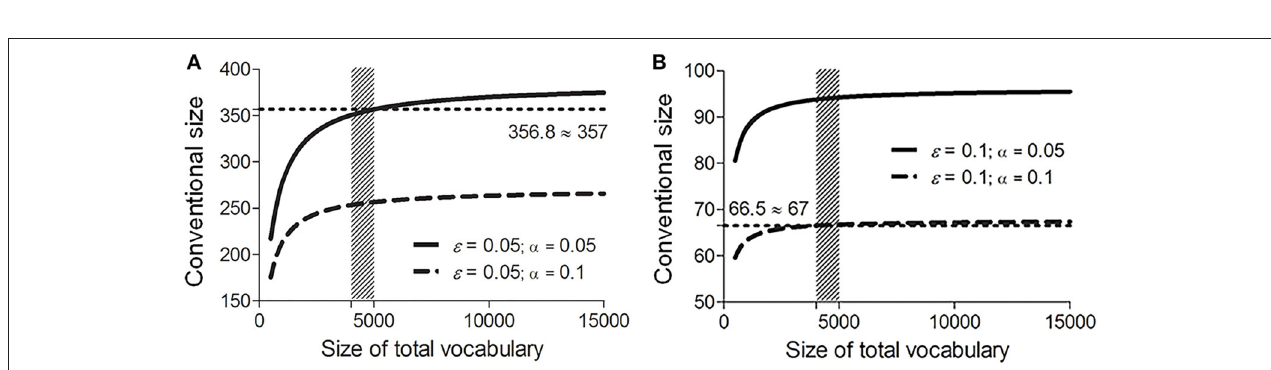
FIGURE 1 | Detection of sound correspondences in assembled words from languages A and B. x i ( i 1 to n ) is the concept in the vocabulary list for = collecting potential cognates, n is the size of the vocabulary list. u A _ i is the word form from A that is semantically equivalent to x i . u B _ i is the word form from B that is x i ) is the probability that some segments in u A _ i and u B _ i show a correspondence. The detecting process can be conceived as a semantically equivalent to x i . p ( y | x = Bernoulli process. The probabilities of showing correspondences in all exemplars follow a 0–1 distribution, and the probabilities for a particular correspondence to occur different times in all exemplars follow a binomial distribution.